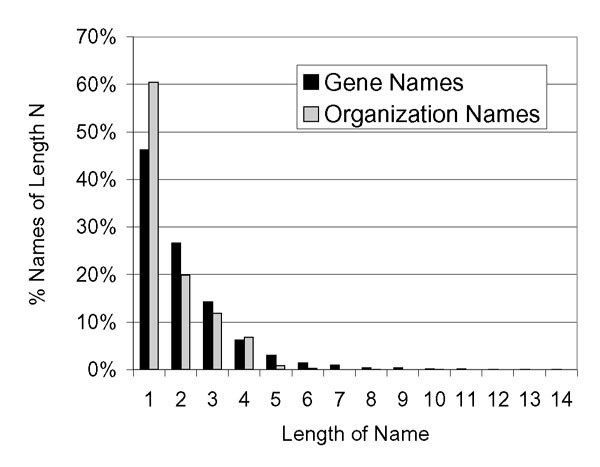
Percent of names of a given length for BioCreAtIvE task 1A gene names and MUC-6 organization names.